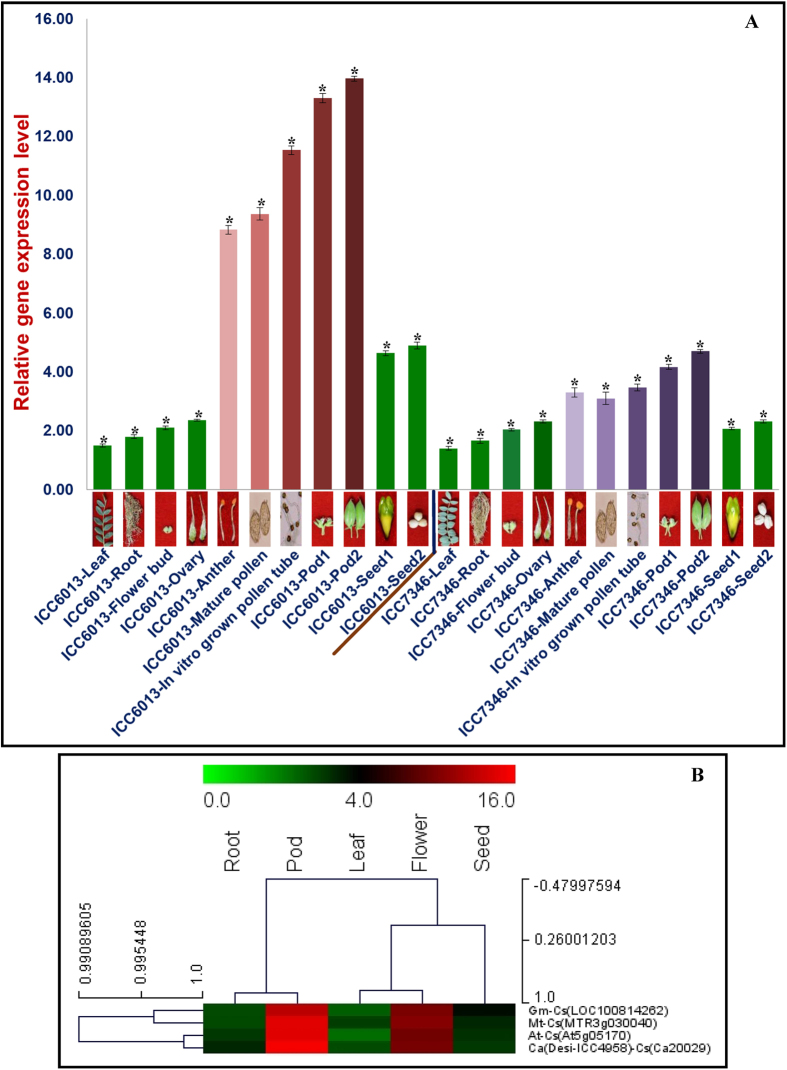
(A) Differential expression profiling of a strong PN- and SN-associated cellulose synthase gene in seven different vegetative (leaf and root) and reproductive (flower bud, ovary, anther, mature pollen and in vitro grown pollen tube) tissues as well as two pod and seed developmental stages of high (ICC 6013) and low (ICC 7346) pod and seed number-containing chickpea accessions using semi-quantitative and quantitative RT-PCR assays. The elongation factor-1 alpha gene was used as the internal control in the RT-PCR. The bars indicate the standard error. *Significance at p ≤ 0.01. (B) Hierarchical cluster display representing the differential expression profile of a strong PN- and SN-associated cellulose synthase gene (validated by GWAS and QTL mapping) determined by comparative global in silico digital transcript profiling. For digital transcript profiling, the whole-genome microarray expression and global transcriptome sequencing data available previously for a similar cellulose synthase gene in different vegetative and reproductive tissues of Arabidopsis, soybean, Medicago and chickpea were used. The colour-scale at the top represents average log signal expression values of genes in various tissues, in which green, black and red signify low, medium and high level of expression, respectively. The tissues and identities of cellulose synthase genes for which the differential expression data available in Glycine max (Gm), Medicago truncatula (Mt), Arabidopsis thaliana (At) and Cicer arietinum (Ca) are mentioned on the top and right-sides of expression map, respectively. We thankfully acknowledge DB and SB for taking this original photograph.